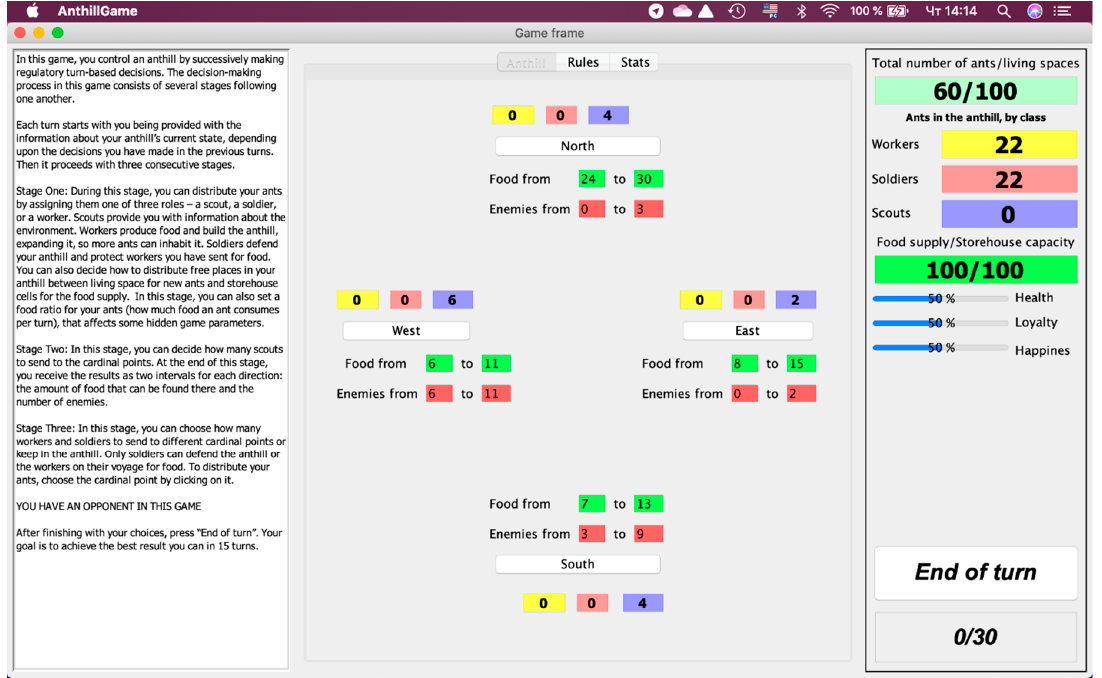
Figure A5. The main screen of “The Anthill” task.